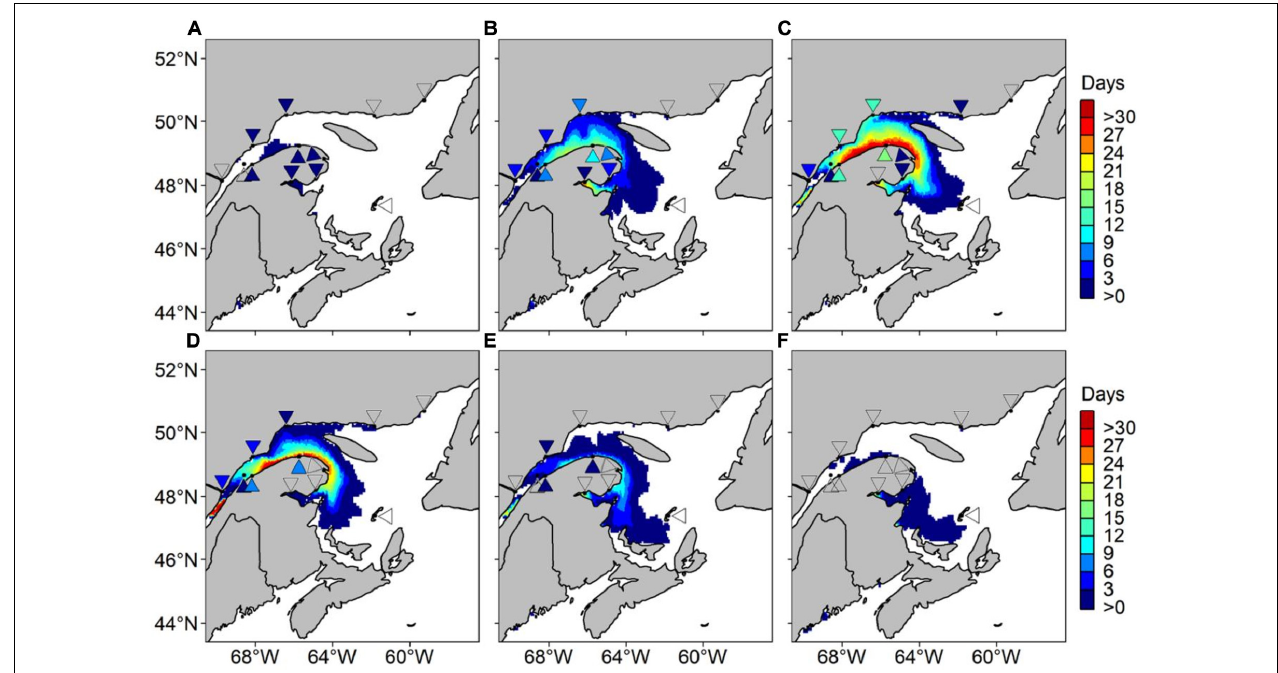
FIGURE 4 | Average number of risk days with Alexandrium catenella ≥ 1000 cells L − 1 for the month of (A) May, (B) June, (C) July, (D) August, (E) September, and (F) October in the Estuary and Gulf of St. Lawrence. Hindcasted risk days (map) and adjusted observed days (reversed triangles) are presented from 1999 to 2008, inclusively.